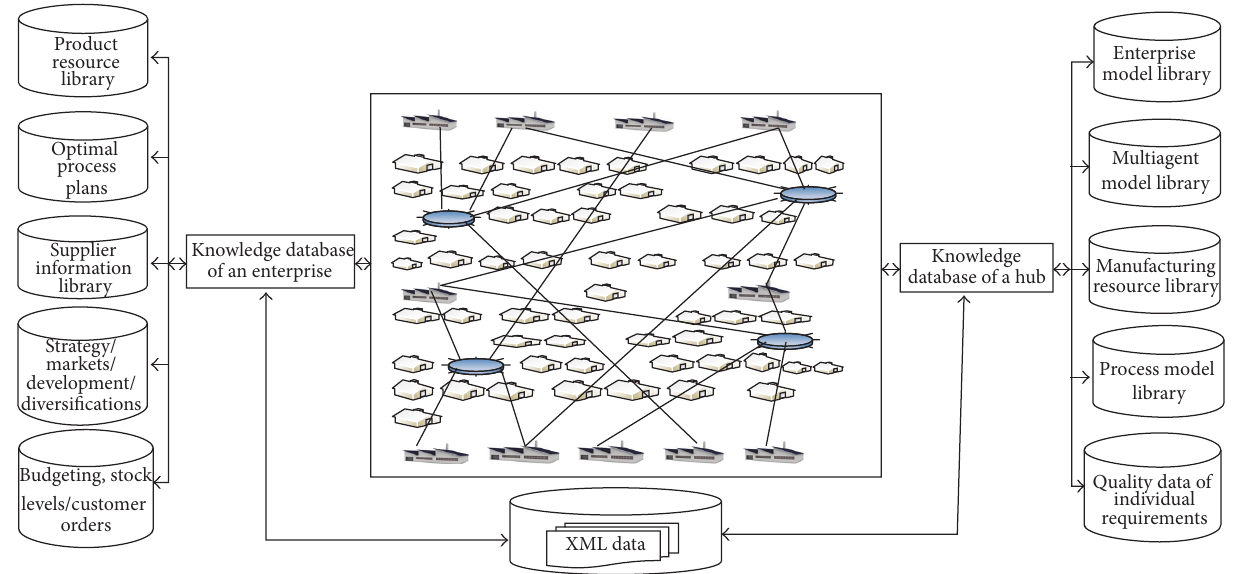
Figure 2: Framework illustrating databases of hub and